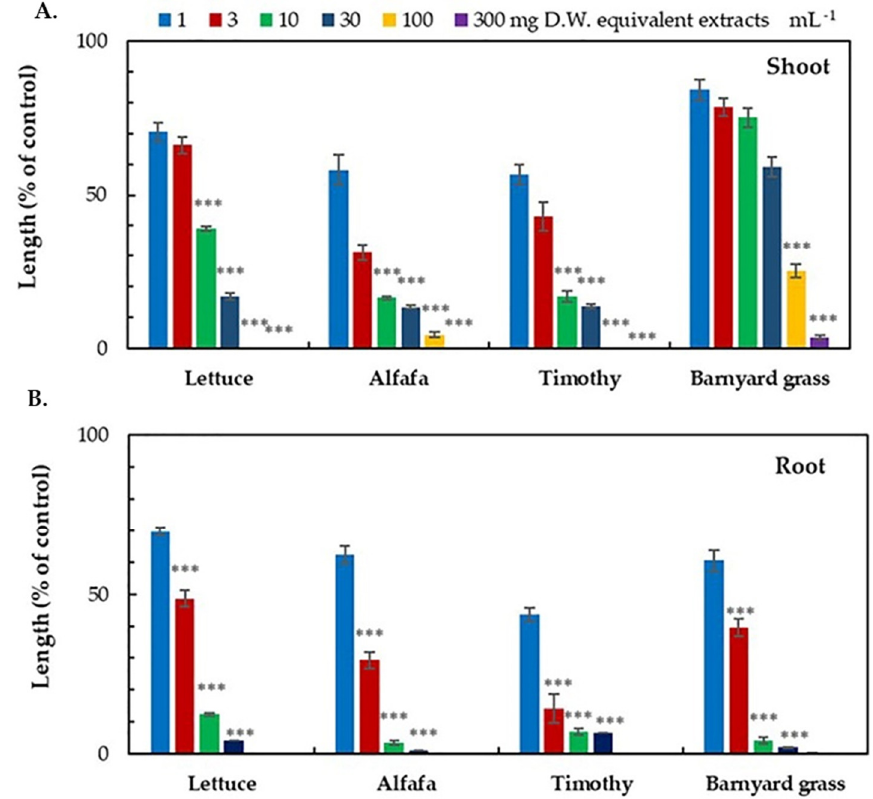
Figure 3. Effect of D. volubilis extracts with the concentrations corresponding to the extracts acquired from 1, 3, 10, 30, 100, and 300 mg D.W. equivalent extract mL − 1 on the ( A ) shoots and ( B ) roots of lettuce ( Lactuca sativa L.), alfalfa ( Medicago sativa L.), timothy ( Phleum pratense L.), and barnyard grass ( Echinochloa crus-galli (L.) P. Beauv.). Asterisks indicate significant differences between treatment and control: *** p < 0.001. Table 1. I 50 value of the D. volubilis extracts for the shoots and roots of lettuce ( Lactuca sativa L.), alfalfa ( Medicago sativa L.), timothy ( Phleum pratense L.), and barnyard grass ( Echinochloa crus-galli (L.) P. Beauv.).